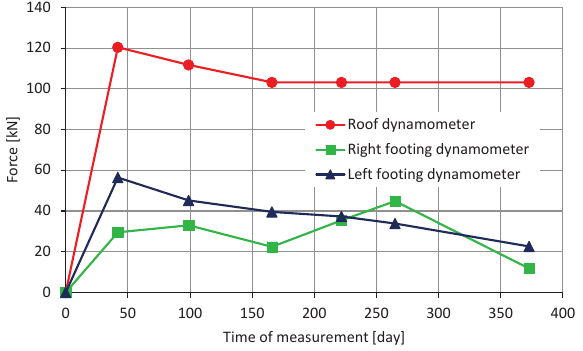
Fig. 1. Overall scheme of the measurement station